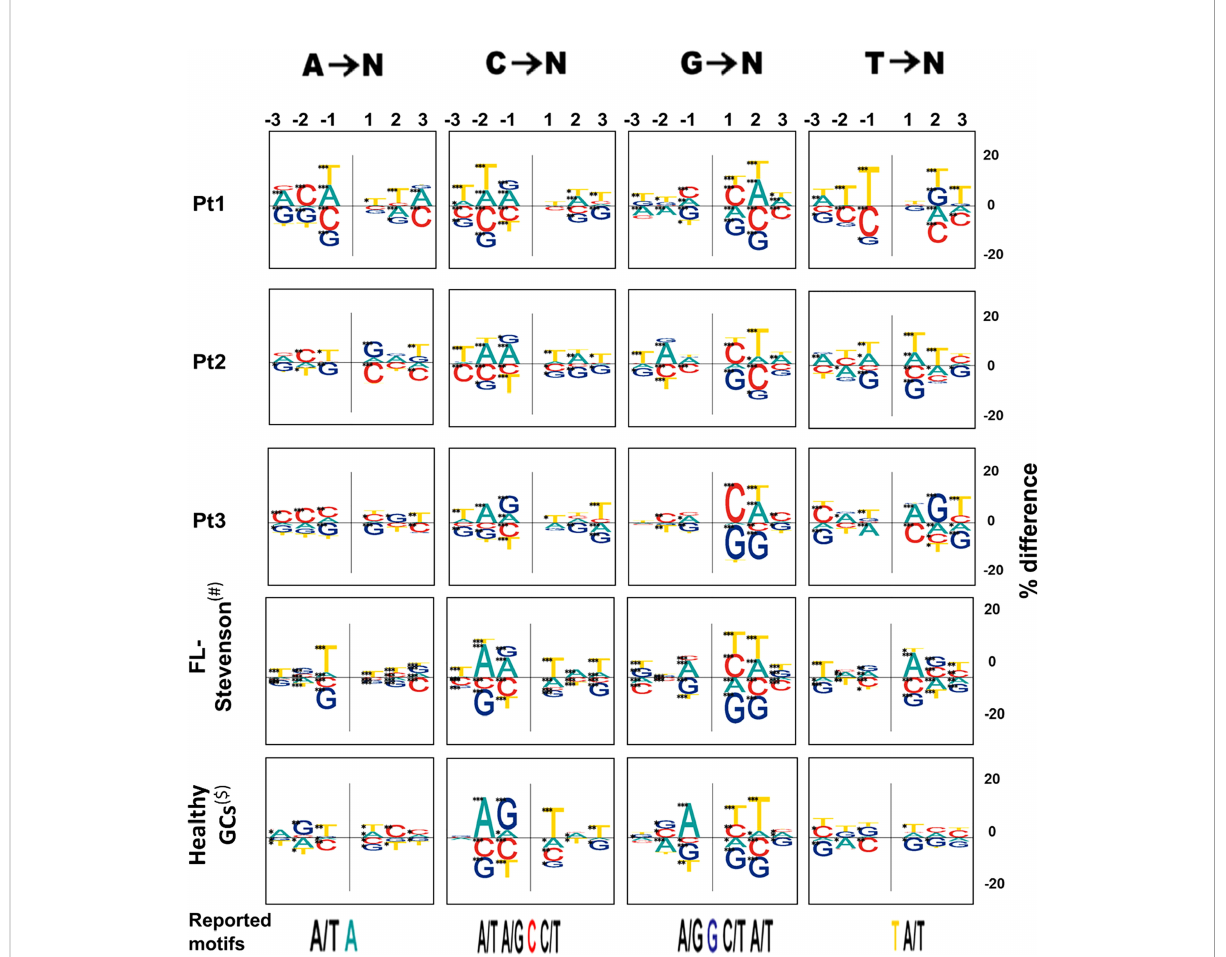
FIGURE 3 Mutation targeting motifs. On the top we show the 3 nucleotides examined upstream and downstream, for each mutated nucleotide, denoted as -1, -2, and -3, for the 3 positions fl anking the mutation upstream and 1, 2, and 3 for those fl anking the mutation downstream. The positive and negative sides of the Y axis denote excess or paucity of the indicated nucleotide in that position, respectively. The size of each letter is given by the “ % difference ” , calculated as percentage of each base at each position fl anking a particular mutation, minus the percentage composition of the GL sequence at that position. Asterisks represent levels of signi fi cance (*p-value < 0.05; **p-value < 0.005; ***p-value < 0.0005). Previously reported motifs are shown at the bottom of the fi gure; the mutated nucleotide is colored and the fl anking nucleotides are shown for reported